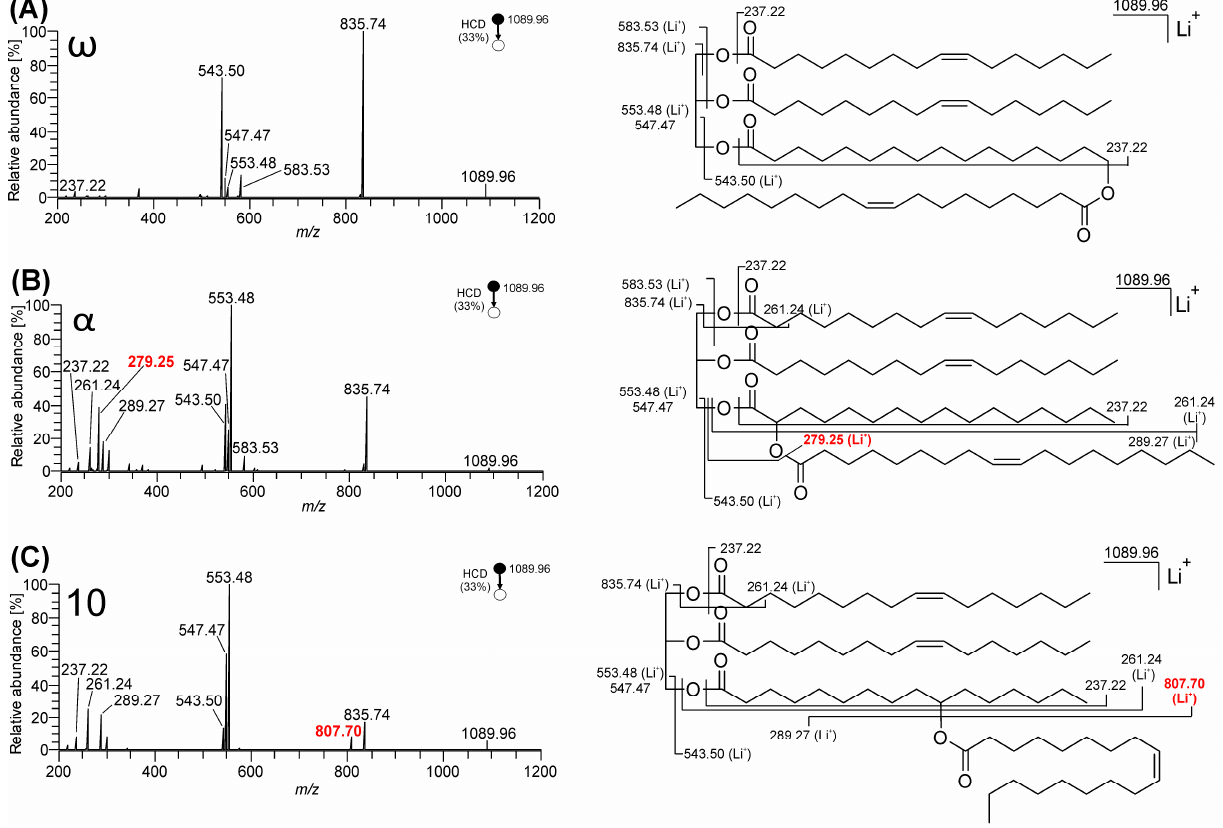
Figure 3. MS 2 HCD spectra of TG-EST [M + Li] + (NCE 33%): ( A ) TG-EST 1 — ω -isomer; ( B ) TG-EST 2 — α -isomer; ( C ) TG-EST 3 —10-isomer. Diagnostic fragment ions for the various positional isomers are highlighted in red.